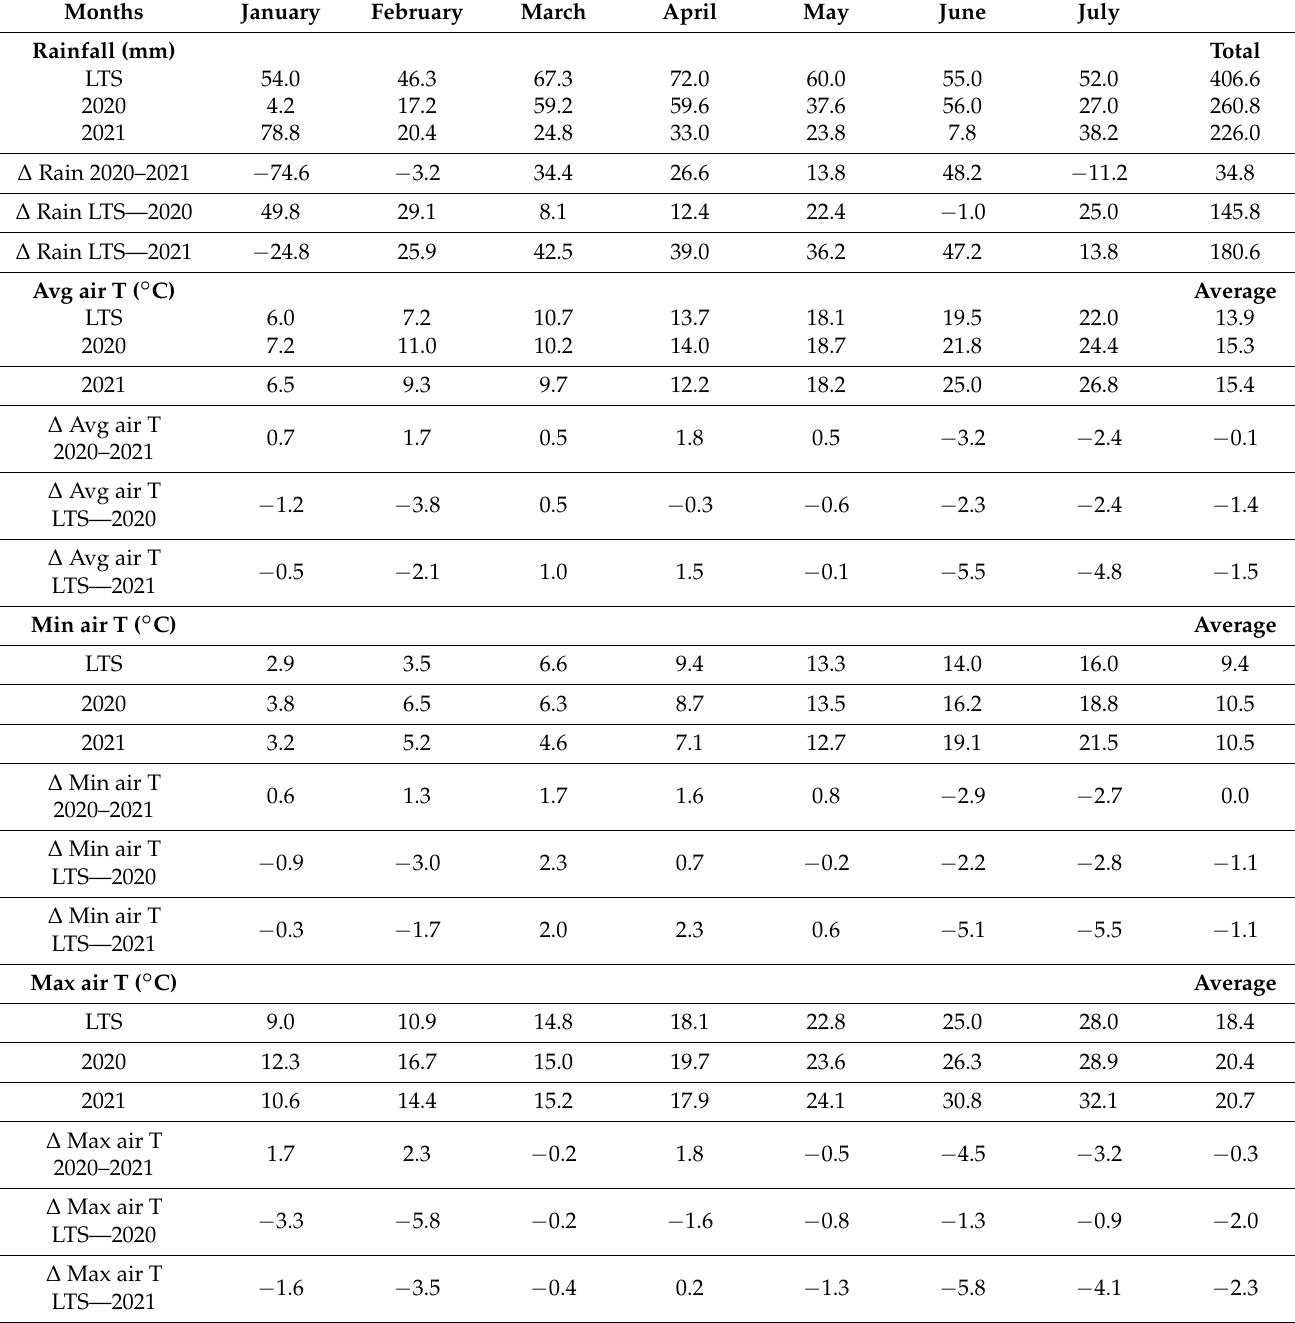
Table 3. Thermo-pluviometric trend related to the sea fennel biological cycle during the 2020 and 2021 seasons compared to LTS (Long-Term Series) historical period